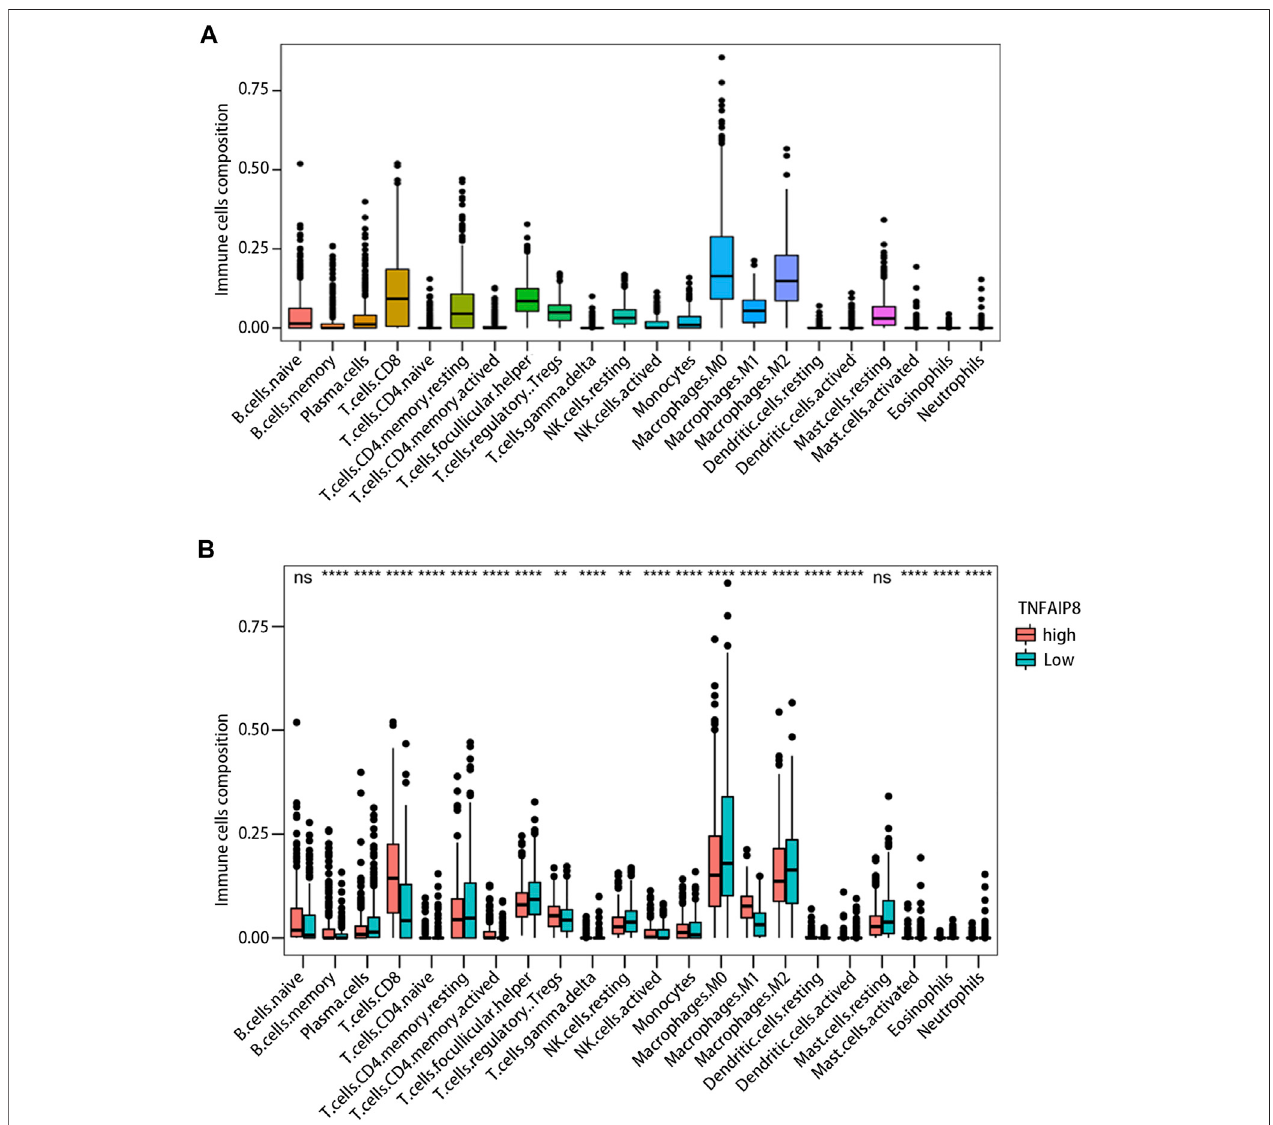
FIGURE 8 | Impact of the TNFAIP8 expression on immune in fi ltration. (A) The proportion of 22 immune cell subtypes in SKCM. (B) Correlations between the TNFAIP8 expression and the in fi ltration abundances of selected immune cells in SKCM through the CIBERSORT algorithm. ** p < 0.01; **** p < 0.0001; ns , no signi fi cant difference ( p >